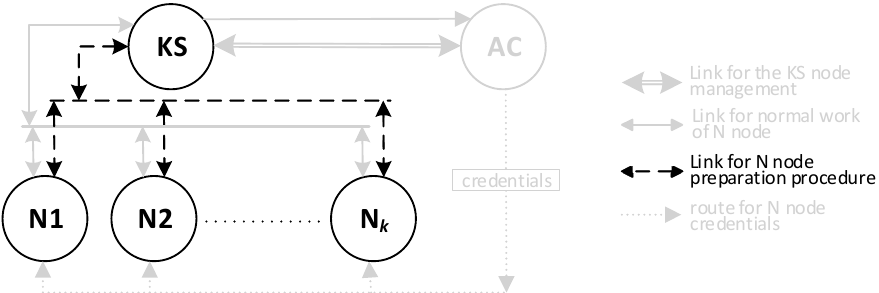
Figure 12. The way the KS node and N node work together during the procedure for registration of the N node.